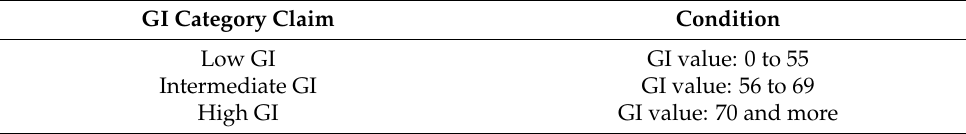
Table 2. South Africa’s Department of Health’s Glycaemic Index (GI) nutrition content claims.